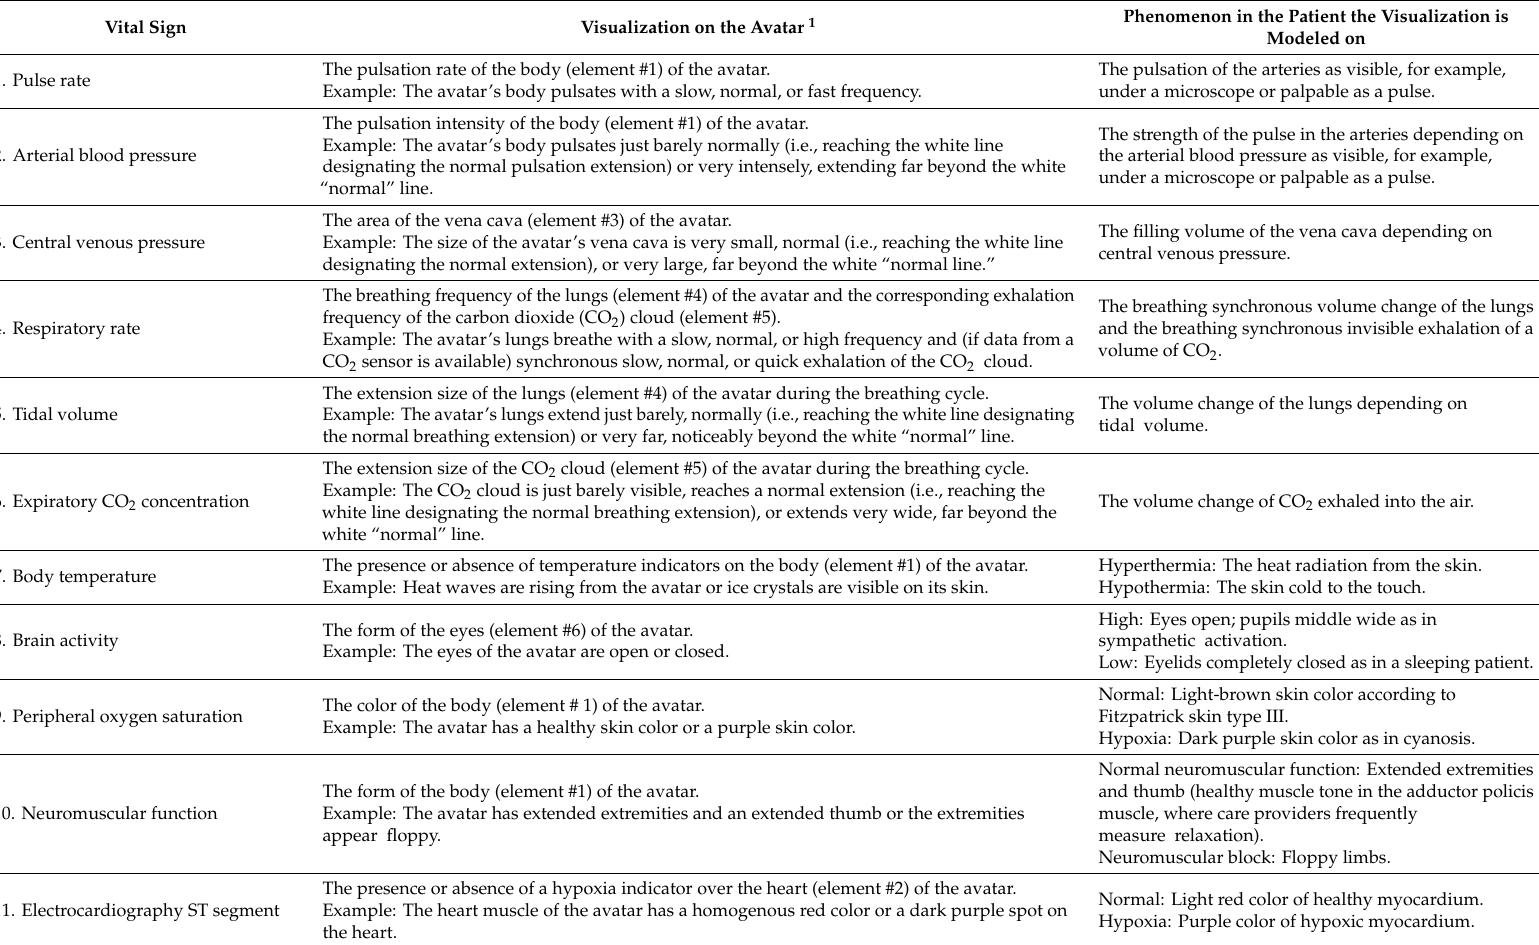
Table 1. Explanations of the avatar visuals and the vital signs they